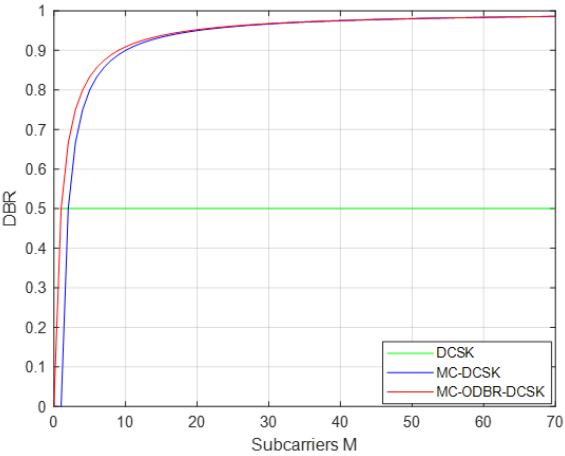
Figure 7. Comparison of DBR of data subcarriers in different